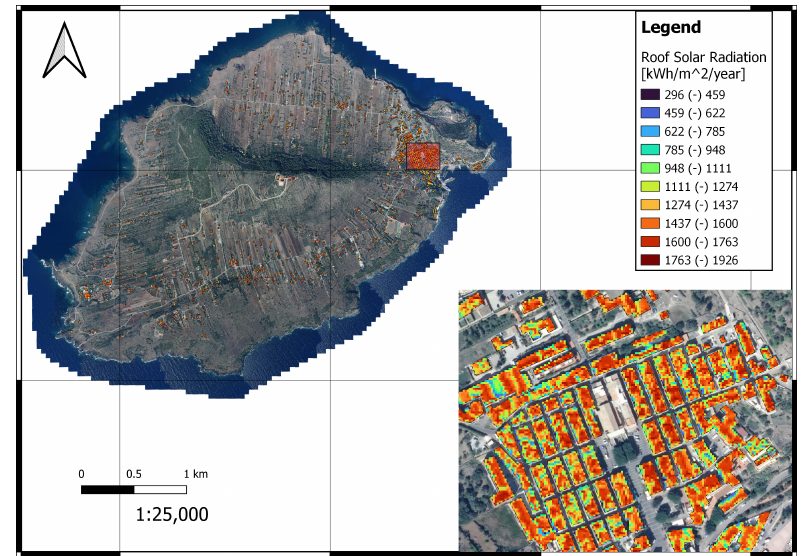
Figure 29. Ustica solar radiation on building